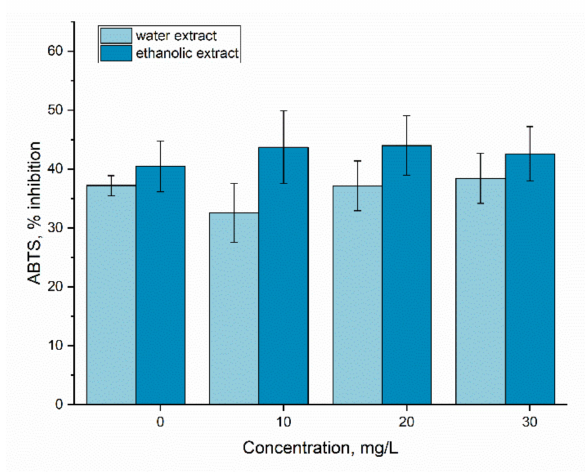
Figure 10. The antioxidant activity of extracts from A. platensis biomass exposed to Er(III) at concen- trations 10–30